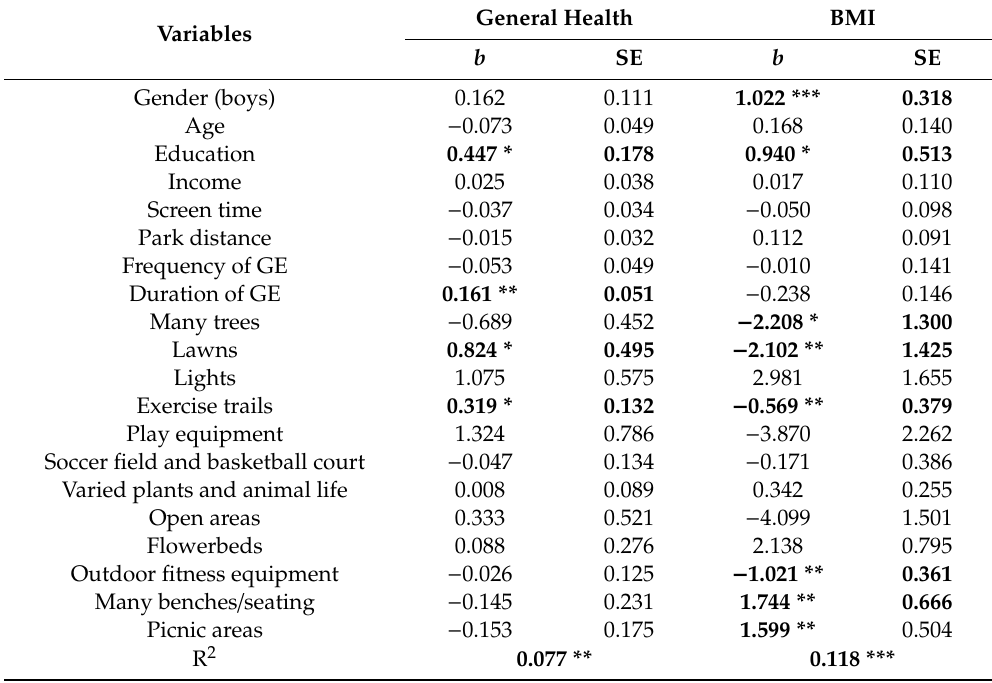
Table 3. Associations between characteristics of UGSs and adolescents’ self-reported general health and BMI.